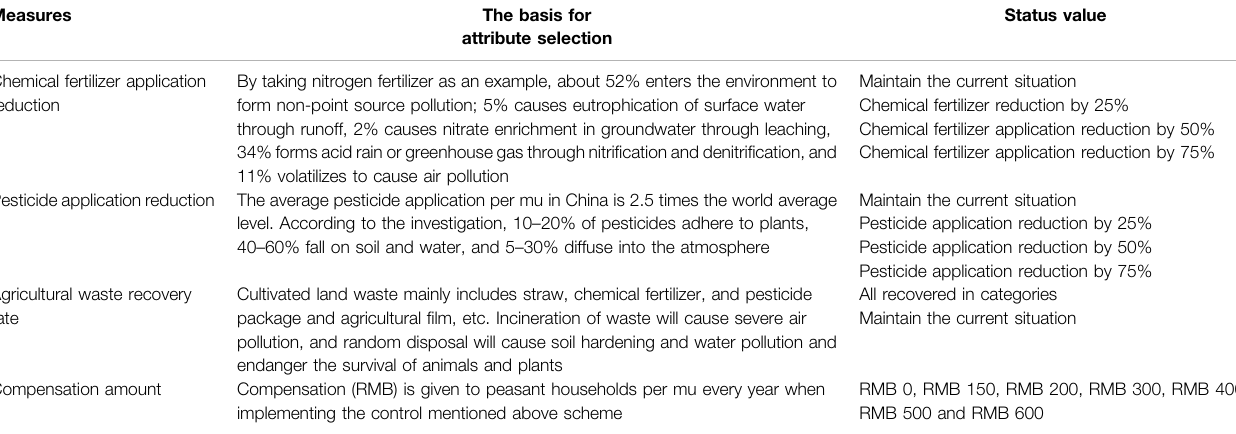
TABLE 1 | Attributes and status values.